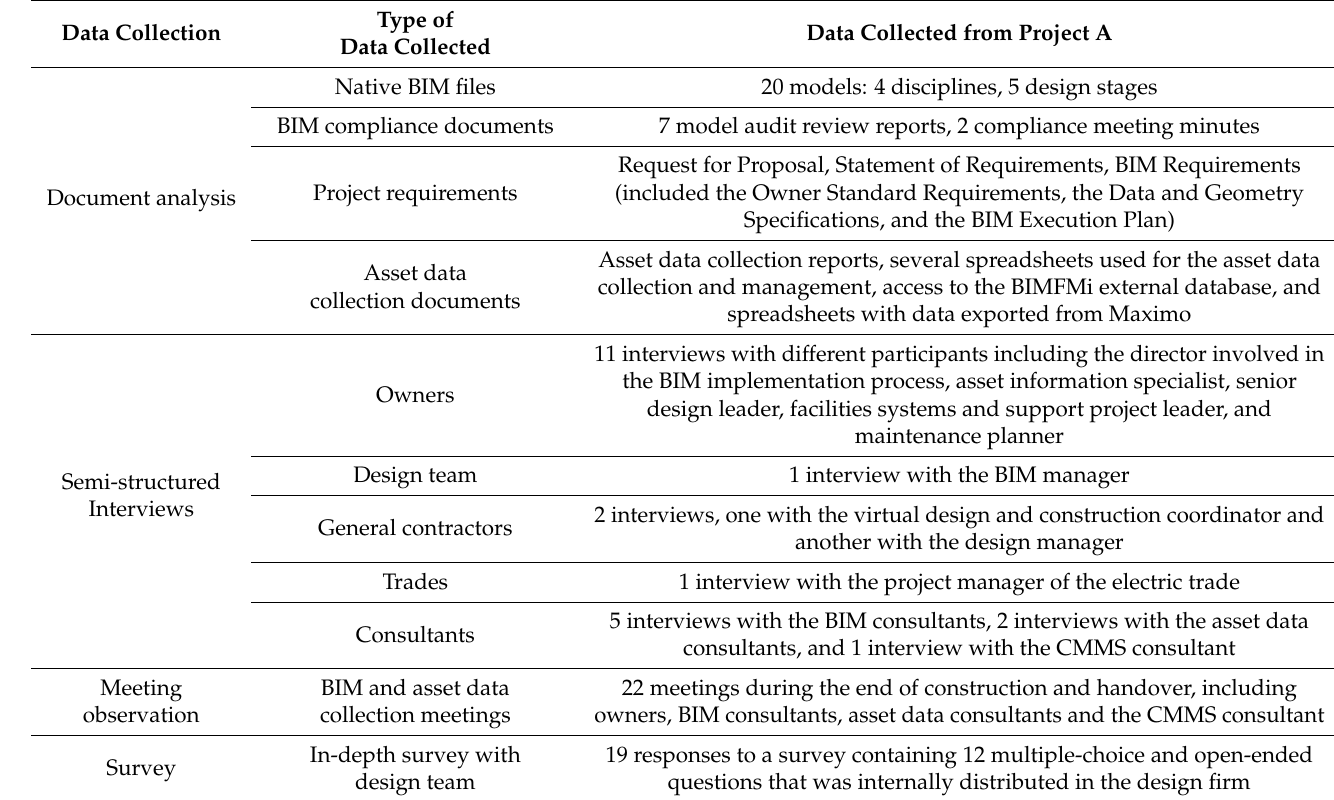
Table 4. Different methods, types of data and quantitative description of the data collection in project